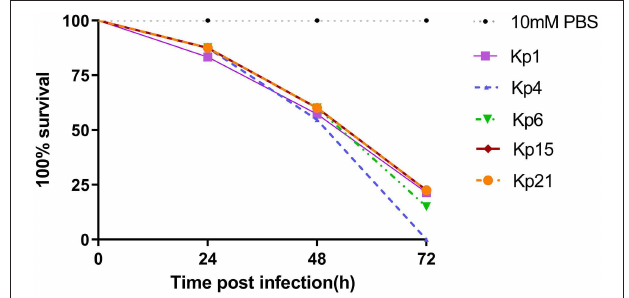
FIGURE 4 | K. pneumoniae infection of G. mellonella larvae induces time-dependent lethality. The effect of 1 × 10 6 colony-forming units (CFU) of each K pneumoniae strain on survival was observed in G. mellonella . The strains were divided into three groups according the hypermucoviscous and resistance phenotypes. High-level drug resistant and hypermucoviscous (Kp1, Kp15). High-level drug resistant and non-hypermucoviscous (Kp4, Kp21). Drug sensitive but hypermucoviscous (Kp6). Larvae were injected with PBS or with 10 6 CFU of Kp1, Kp4, Kp6, Kp15, and Kp21. The survival was monitored over 72h post-infection. Mortality of larvae infected with Kp1, Kp4, Kp6, Kp15, and Kp21 were